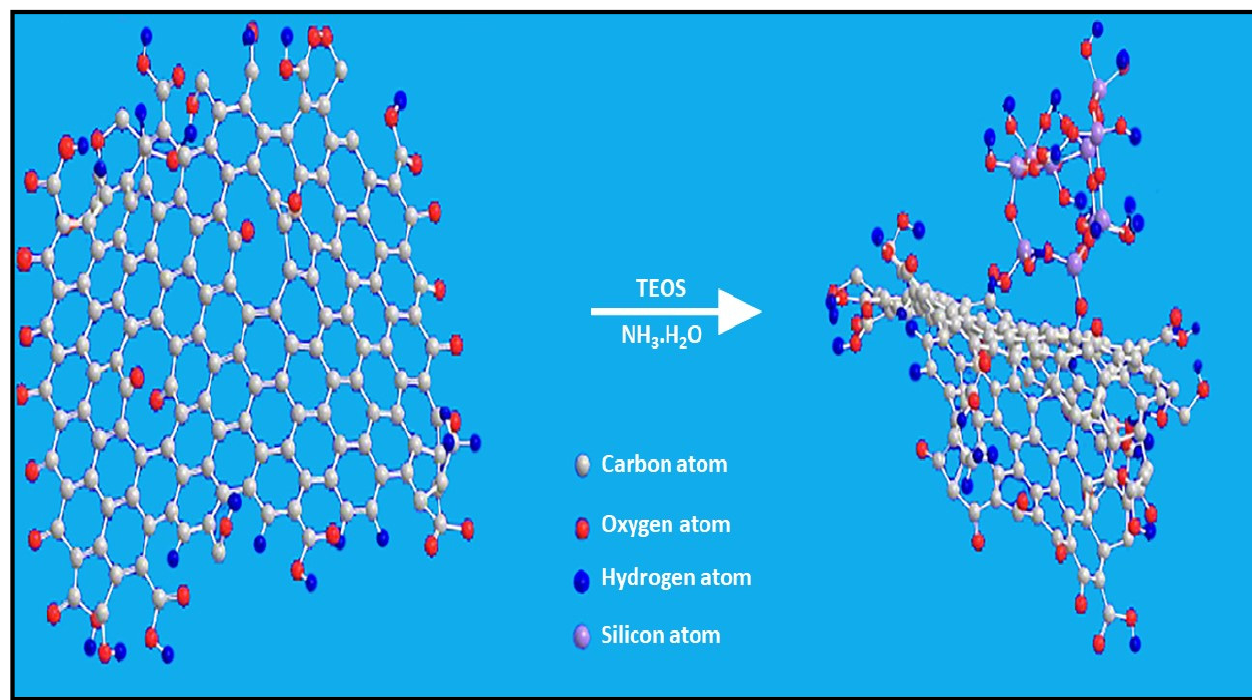
Figure 13. TEM image of ( A ) Graphene oxide (GO) nanosheets; ( B ) silicon dioxide-Graphene oxide (SiO 2 -GO) nanosheets. Reprinted with permission from ref. [57]. © 201 6 Elsevier B.V.